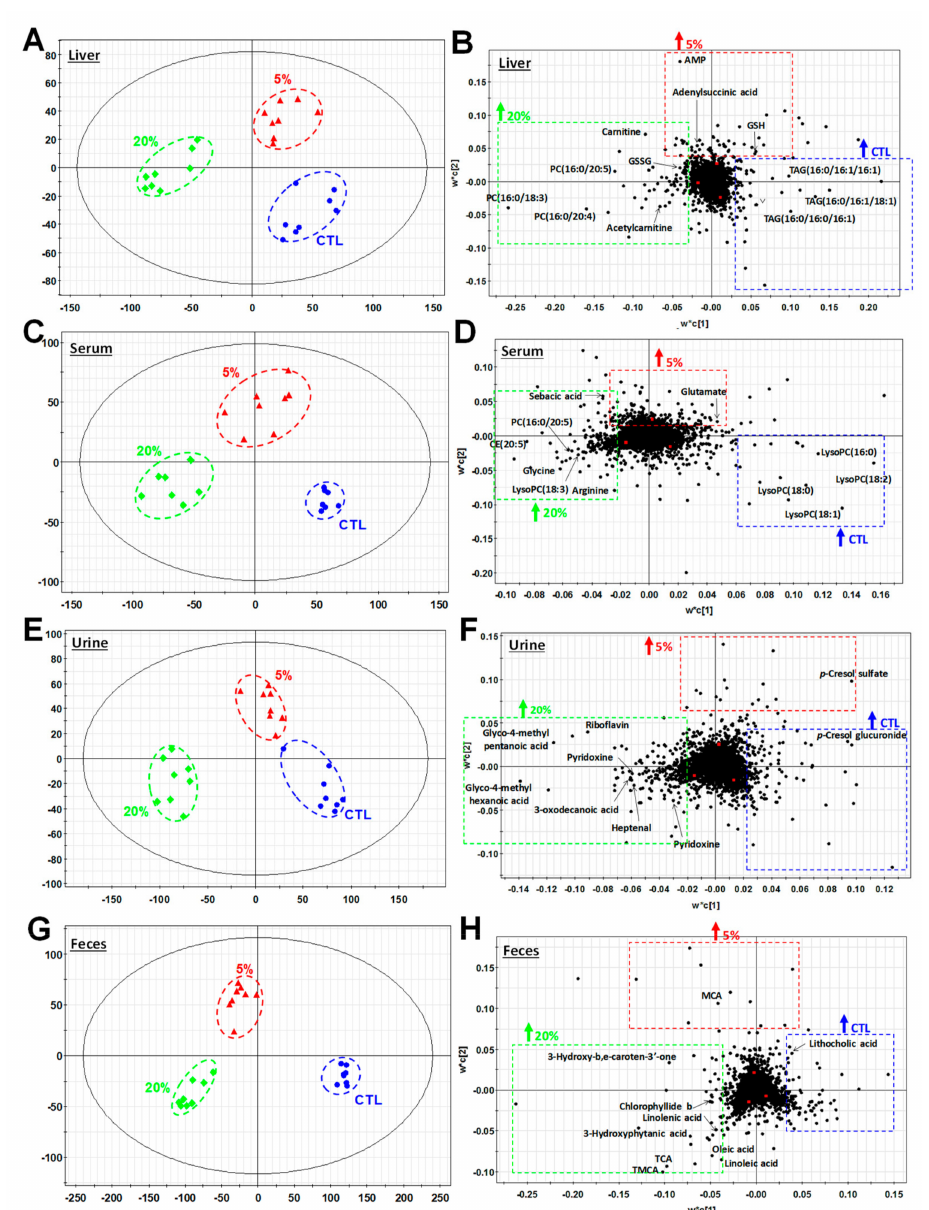
Figure 3. E ff ects of Scenedesmus diets on hepatic, serum, urinary, fecal metabolomes. Data from LC-MS analysis of liver extract, serum, urine and fecal extract were processed by supervised partial least squares-discriminant analysis (PLS-DA) modeling. The associations of metabolites representing each of the three groups of mice ( n = 8 / group) are shown in the scores plots. Selective metabolite markers correlating with the experimental diets are labeled in the loadings plots. ( A ) Scores plot of a PLS-DA model on liver extracts. ( B ) Loadings plot of a PLS-DA model on liver extracts. ( C ) Scores plot of a PLS-DA model on serum samples. ( D ) Loadings plot of a PLS-DA model on serum samples. ( E ) Scores plot of a PLS-DA model on urine samples. ( F ) Loadings plot of a PLS-DA model on urine samples. ( G ) Scores plot of a PLS-DA model on fecal samples. ( H ) Loadings plot of a PLS-DA model on fecal samples. The symbol “ ↑ ” in the loadings plot indicates positive correlation with individual